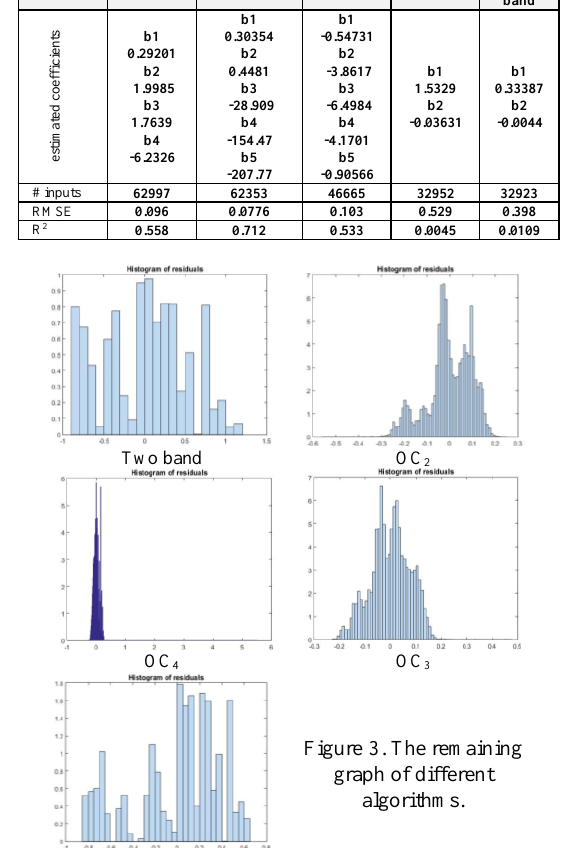
Table 2. Estimated RMSE and R 2 values for different algorithms and related coefficient.